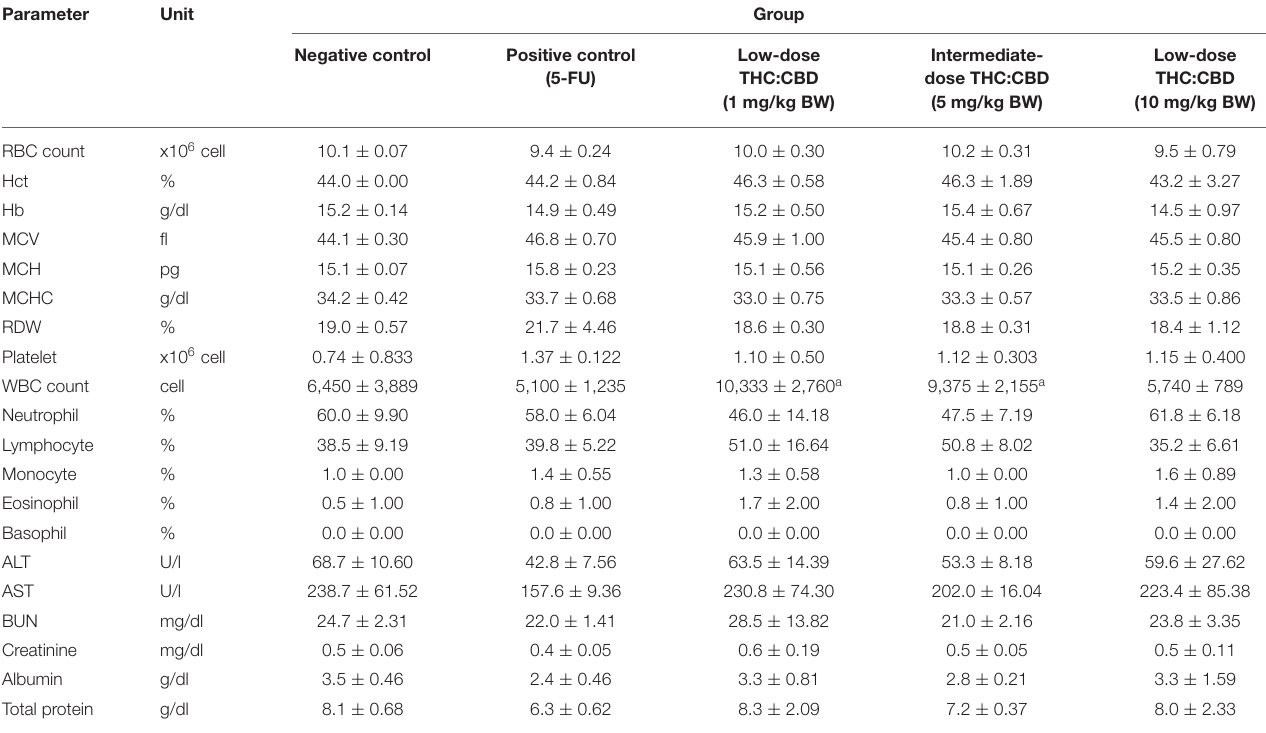
TABLE 2 | Hematological and blood chemistry profiles of mice. Parameter